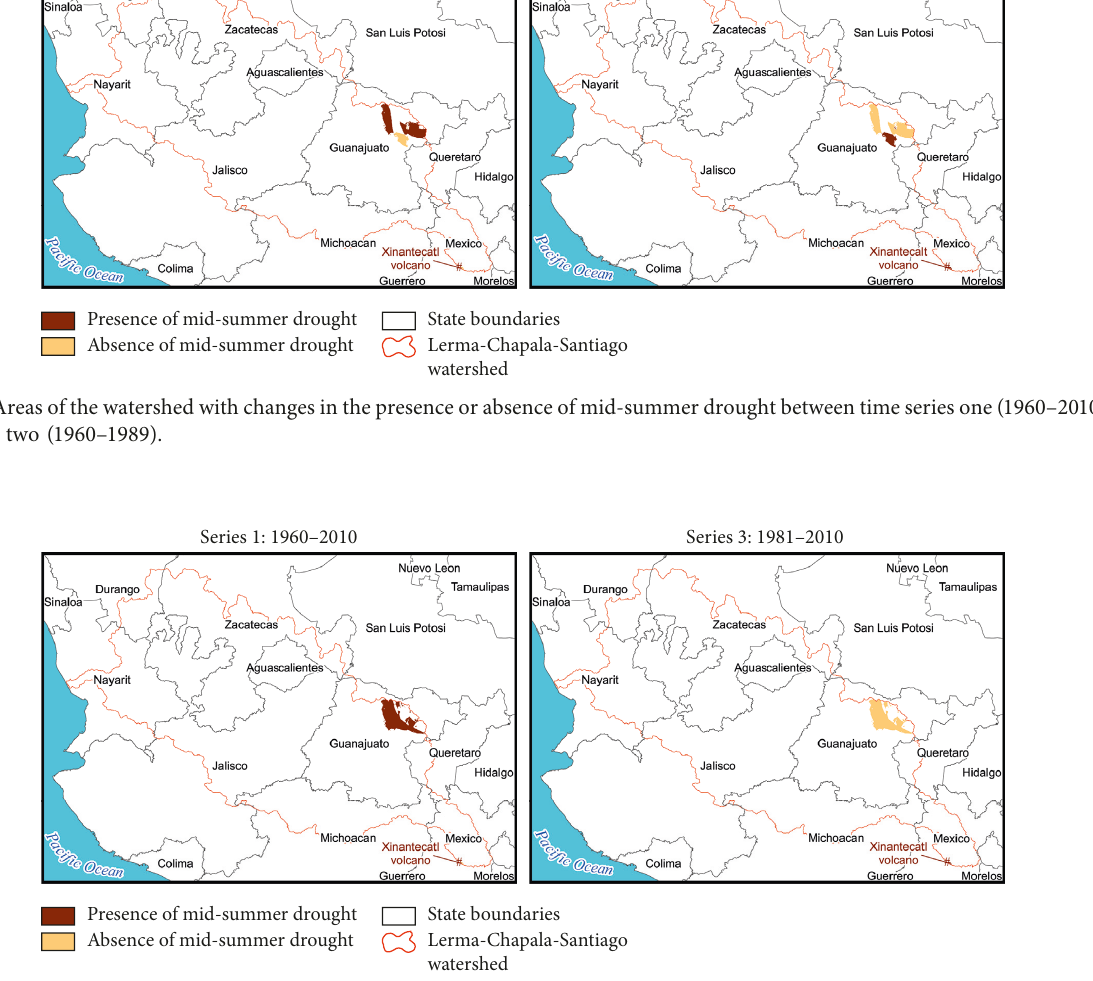
Figure 10: Areas of the watershed with changes in the presence or absence of mid-summer drought between time series one (1960–2010) and time series three (1981–2010).